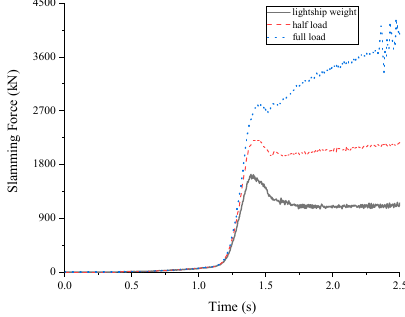
Figure 22. Slamming force of the stern at each loading condition.